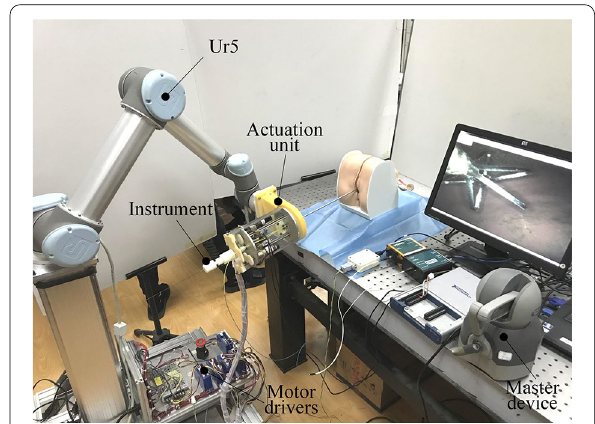
Figure 5 Overview of robotic